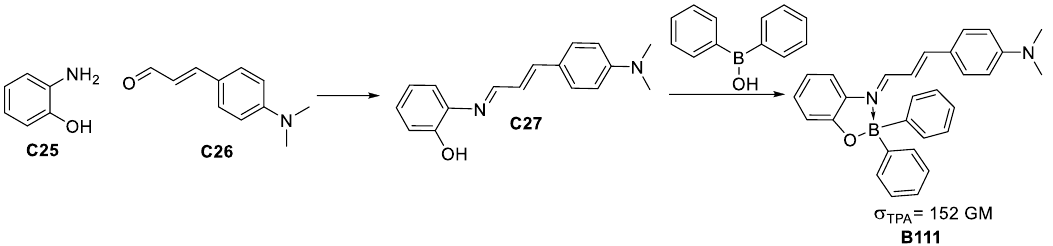
Figure 34. Scheme for obtaining a TPA-responsive boronate of major structural accessibility and σ TPA value.